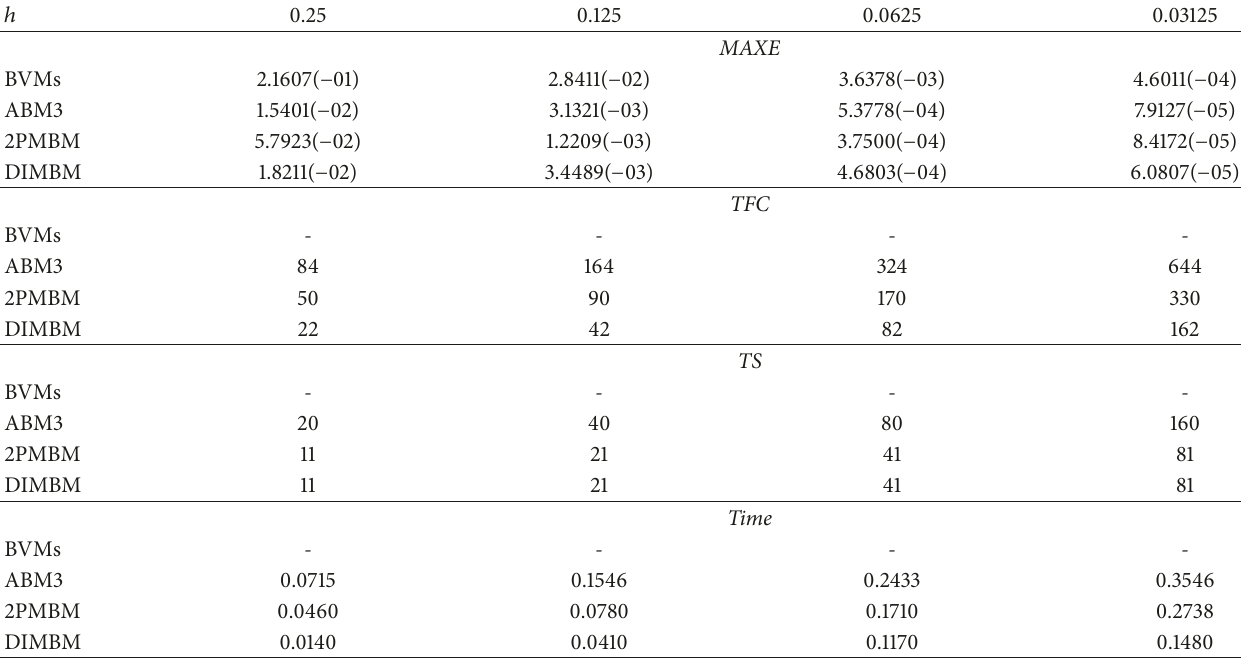
Table 2: Numerical results for Example 2.